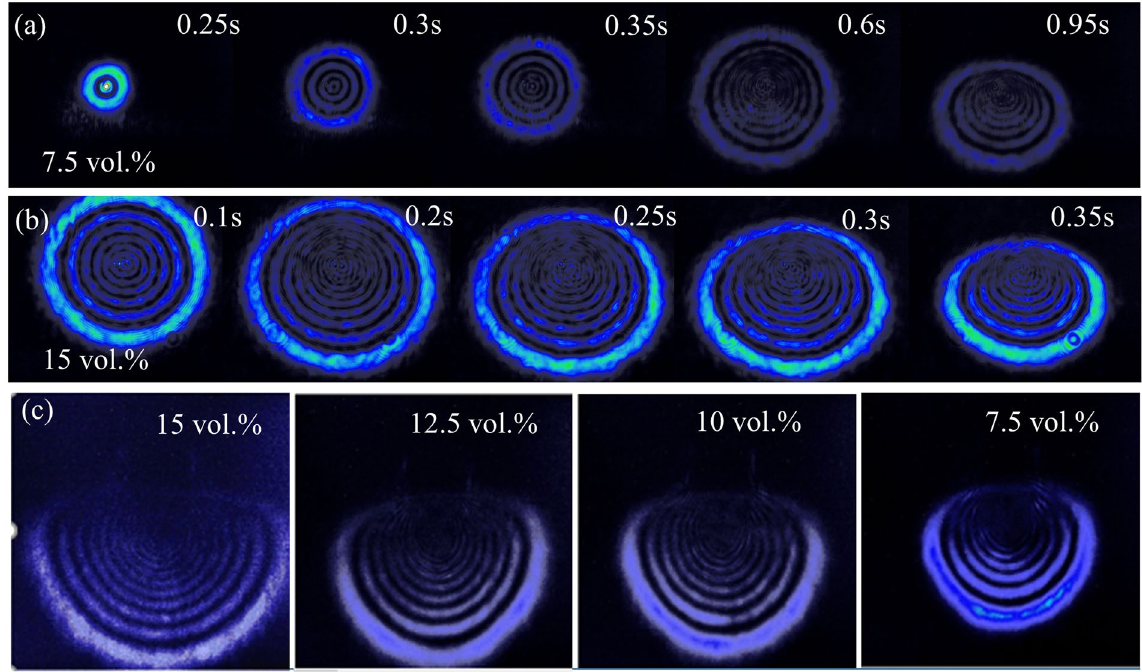
Figure 4. Snapshots of the pattern formation of: ( a ) Diluent BP solution dispersions (~7.5 vol.%); ( b ) 15 vol.% dispersion under the irradiance of 100 mW and ( c ) Different concentration under the irradiance of 140 mW at 1061 nm laser beam